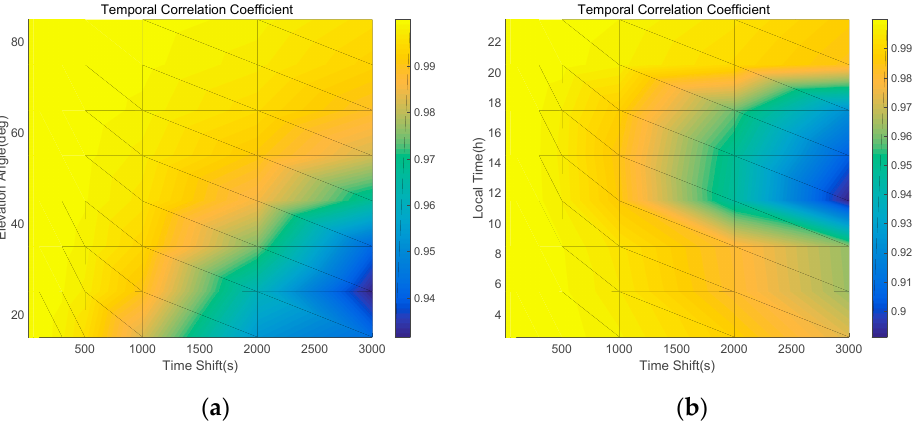
Figure 5. Temporal correlation coefficient of the ionospheric delay due to various time shifts, elevation angles ( a ), and local time ( b ).